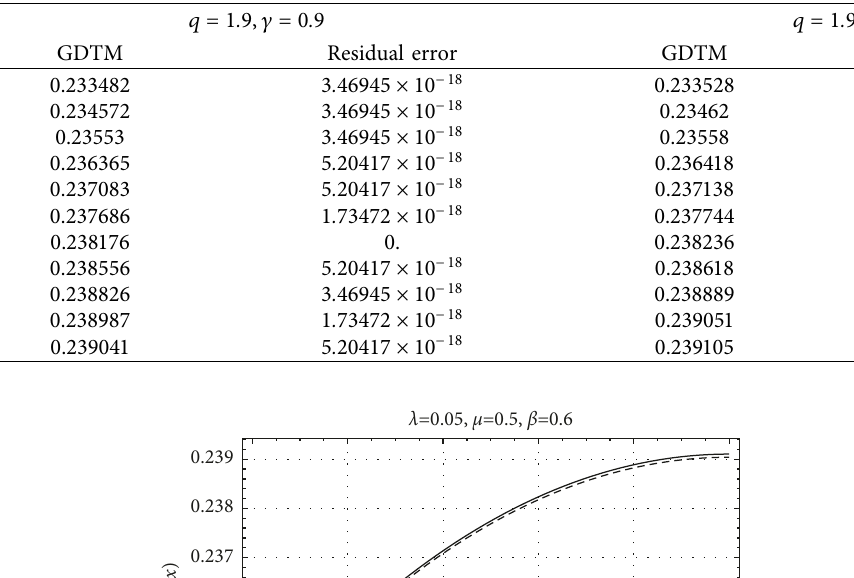
Table 5: Numerical solutions for λ � 0 . 05 , μ � 0 . 5 , β � 0 . 6.